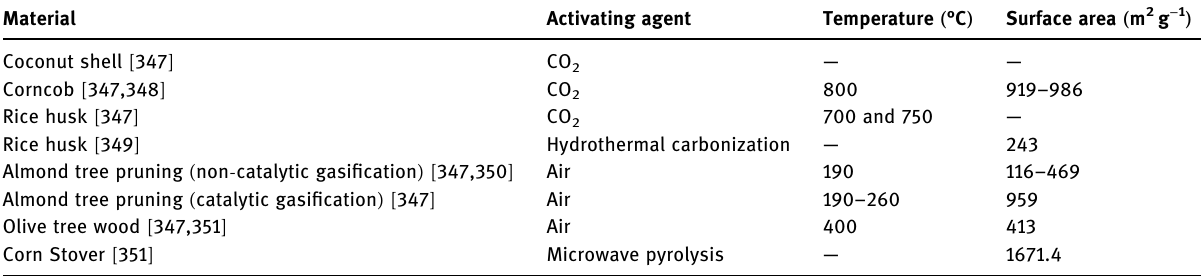
Table 2: Di ff erent physical methods for AC production from biomass with corresponding properties